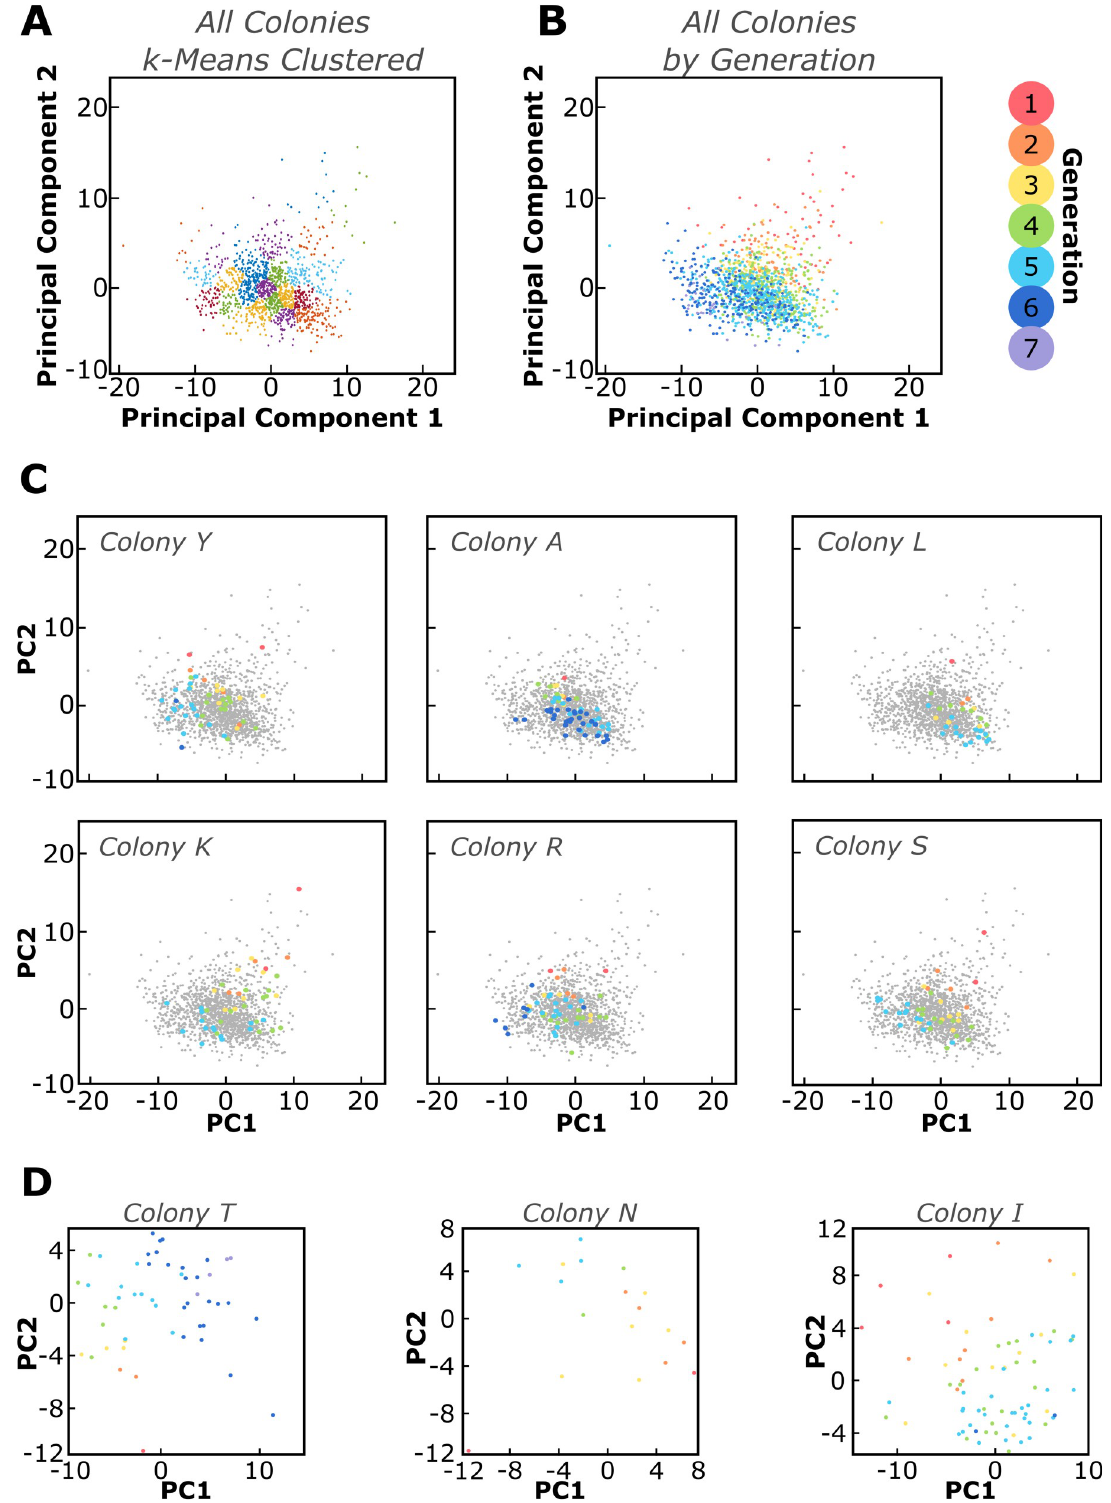
Fig 3. Principal component analysis revealed a trend in generation associated with cell behavior. (A) A total of 128 variables (listed in Methods and S2 Table) related to morphology, location, proliferation, and association with neighboring cells were analyzed using principal component analysis (PCA) for 1384 cells belonging to 28 colonies. k-means clustering revealed no clusters that were especially